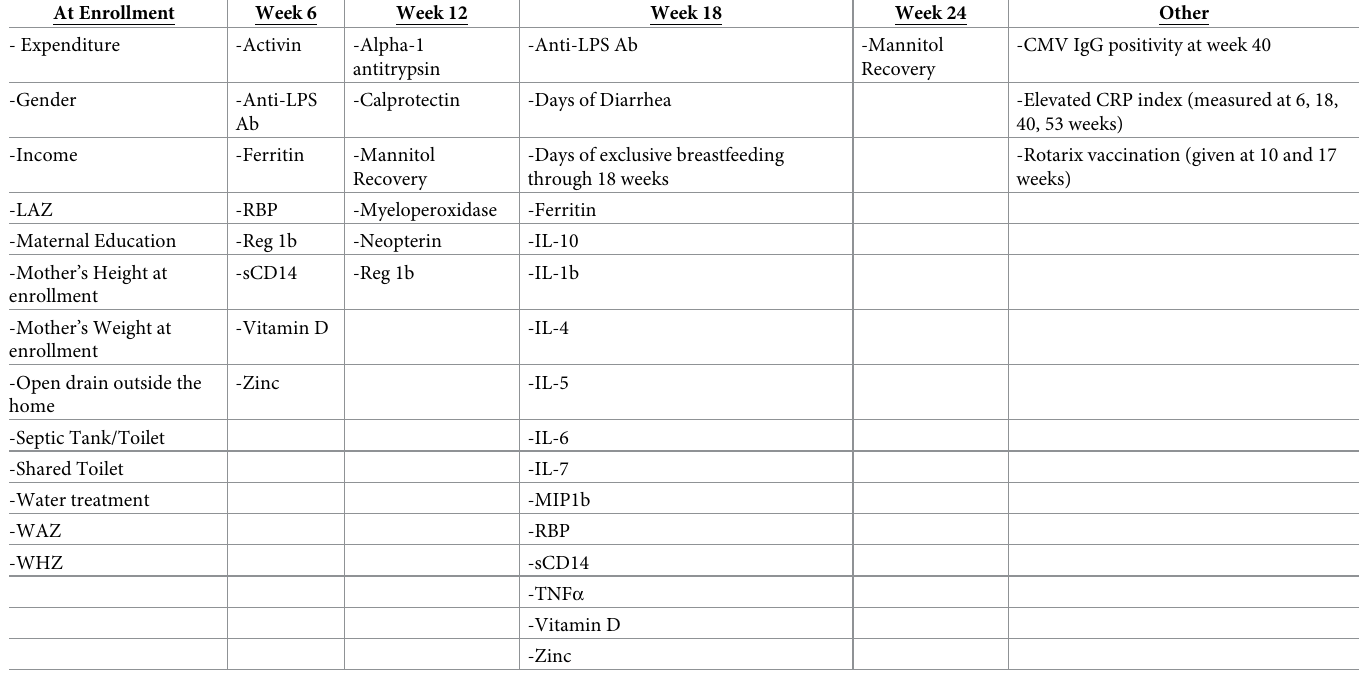
Table 1. Variables measured in the PROVIDE study utilized in random forests models to predict linear growth and Bayley-III neurodevelopmental scores at two years of age.